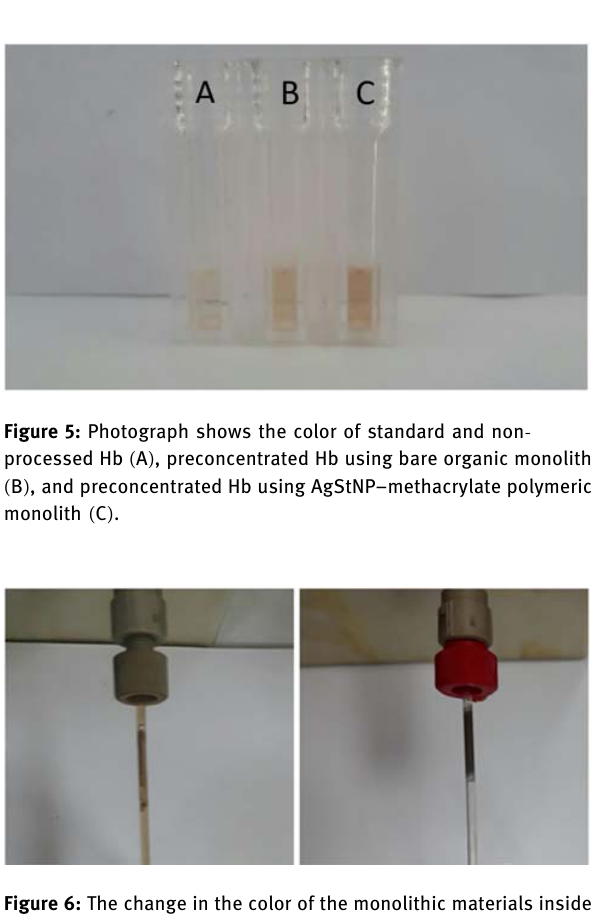
Figure 6: The change in the color of the monolithic materials inside the micropipette while loading Myo, due to immobilization of Myo into the surface of bare organic monolith ( left ) and AgStNP – methacrylate polymeric monolith ( right ) .